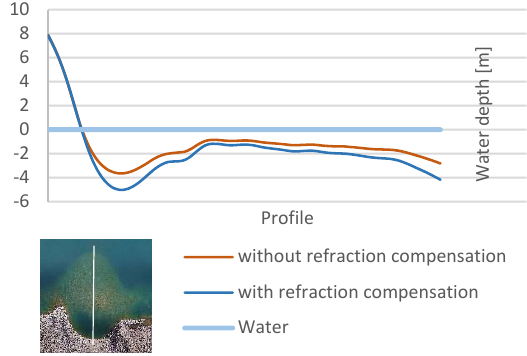
Figure 10: Comparison of DEM heights along a